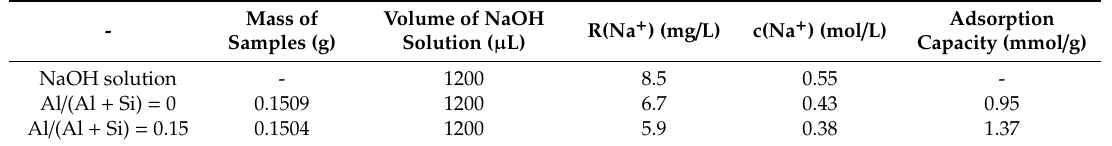
Table 2. Adsorption capacity of specimens to Na +